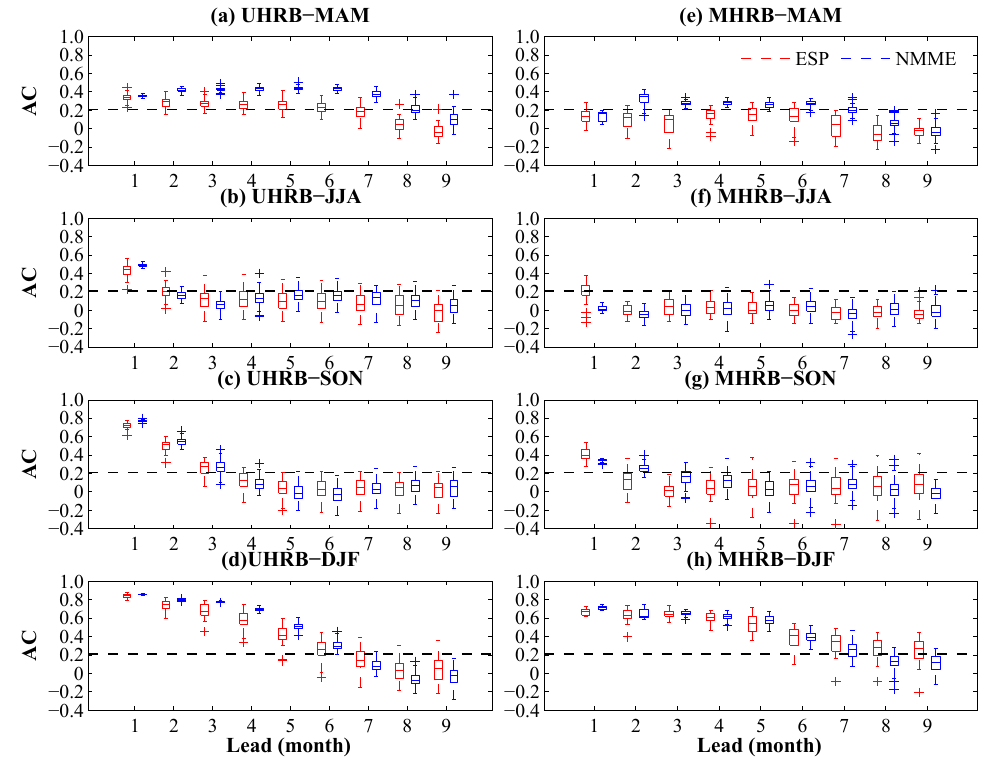
Figure 5. Anomaly correlation (AC) of the forecast of seasonal SSI1. The red box plots show the spread of AC of each member from NMME, and the blue box plots show that from ESP. The blue (red) crosses show the outliers for NMME (ESP) forecast skill. The dashed black line indicates the threshold (AC = 0.21) of 95% confidence intervals calculated from the t test. The predictions and simulations are carried out with the human activities module switched